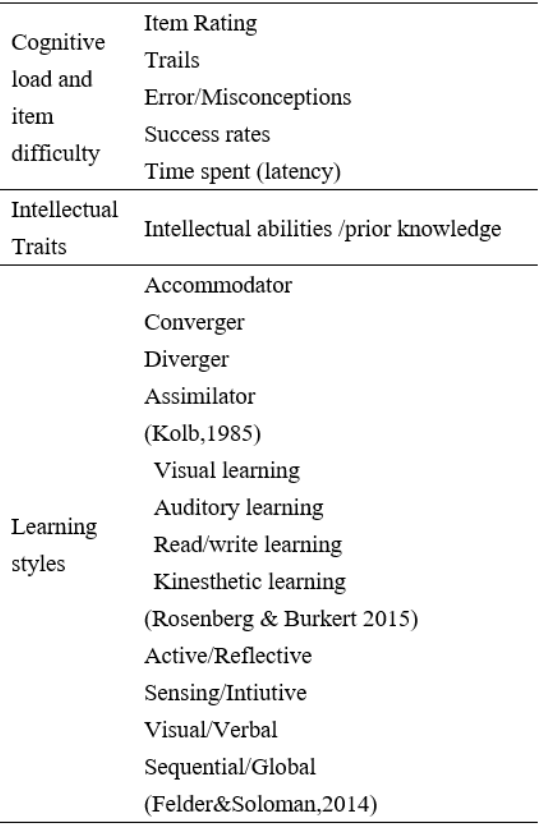
Table 3. Followed values and variables for Pedagogical